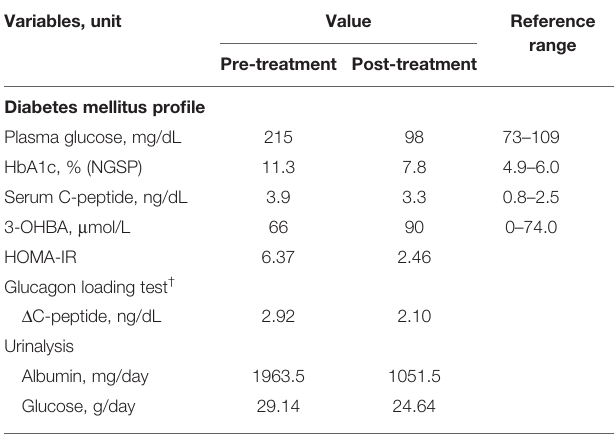
TABLE 1 | Laboratory fi ndings of glucose metabolisms evaluated pre- and post- treatment with an SGLT2 inhibitor. Variables,